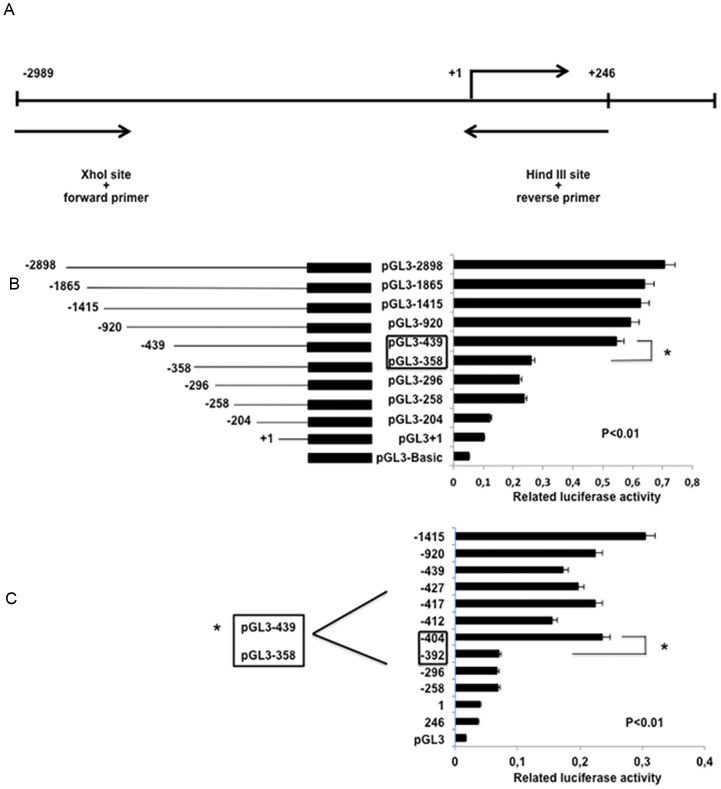
Identification of transcription factor binding site (TFBS) of HOXB9 promoter.(A) HOXB9 promoter region and primer sets used for cloning. (B) Reporter plasmids with the HOXB9 promoter region and deletion variants were constructed by inserting the PCR product of the putative HOXB9 promoter region. The numbers of the left side of graph indicate the full length of HOXB9 promoter and deletion variants, the right side shows transcriptional activity of each variant in MDA-MB231 cells. The difference in relative luciferase activity between pGL3-439 and pGL3-358 constructs was recorded. (*p<0.01) (C) Additional deletion plasmids between bps −439 and −358 of the promoter were constructed to identify the exact position of TFBS and gap of gene activity in that region was recorded each time when assay was repeated. The difference in relative luciferase activity between pGL3-404 and pGL3-392 constructs was significant (*p<0.01).